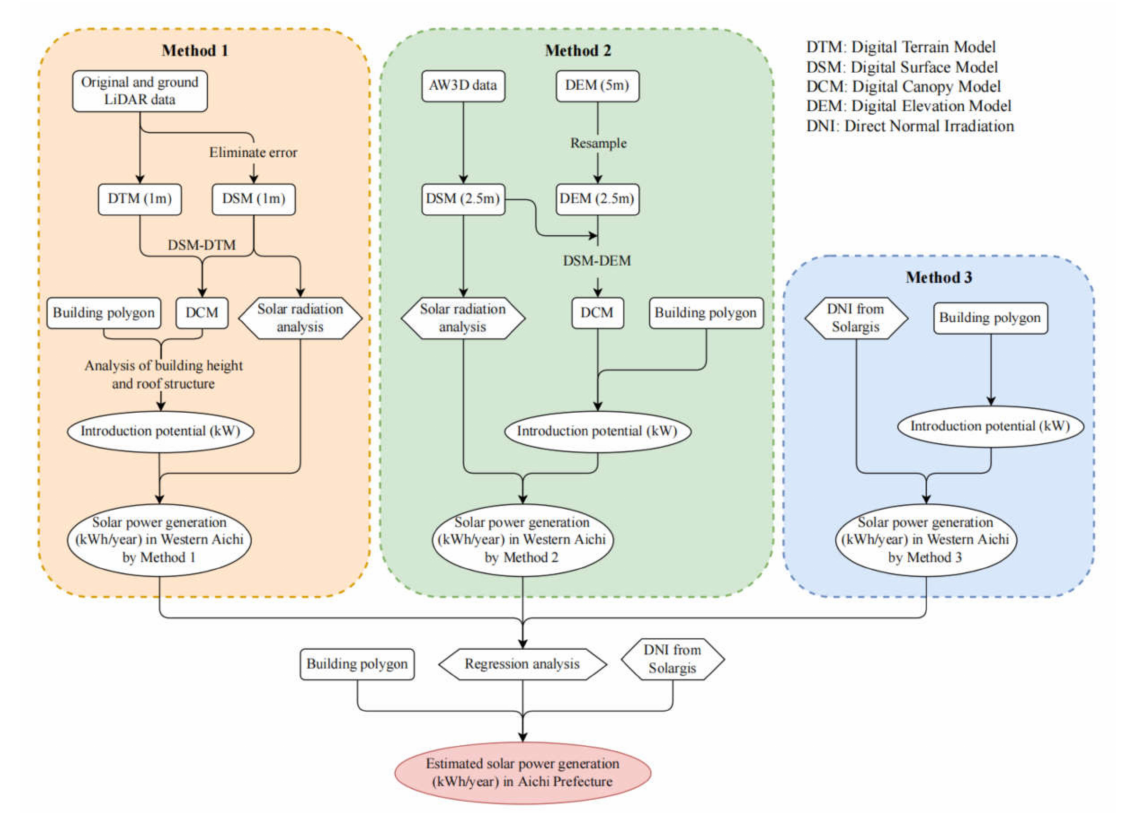
Figure 1. Structural framework of this